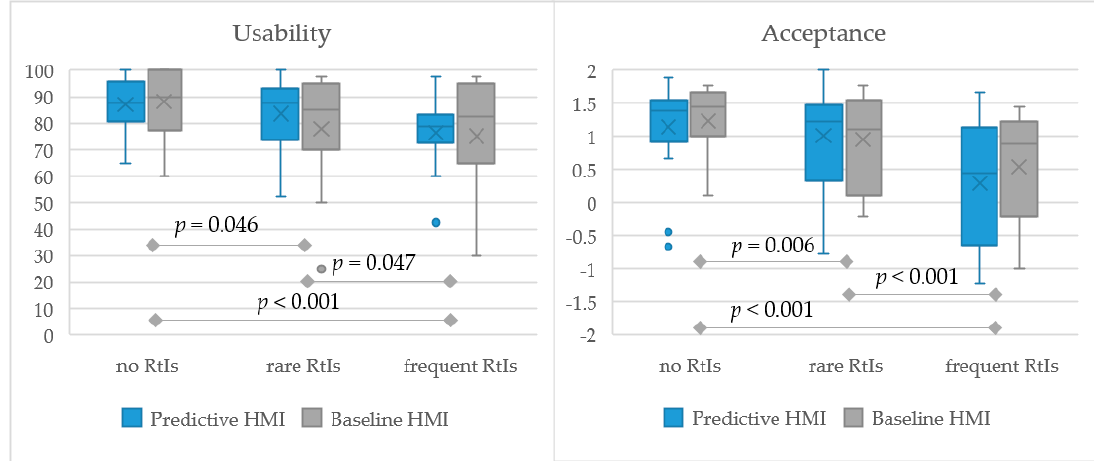
Figure 4. Boxplots for usability (System Usability Score) and acceptance (van der Laan acceptance questionnaire). RtI, requests to intervene.